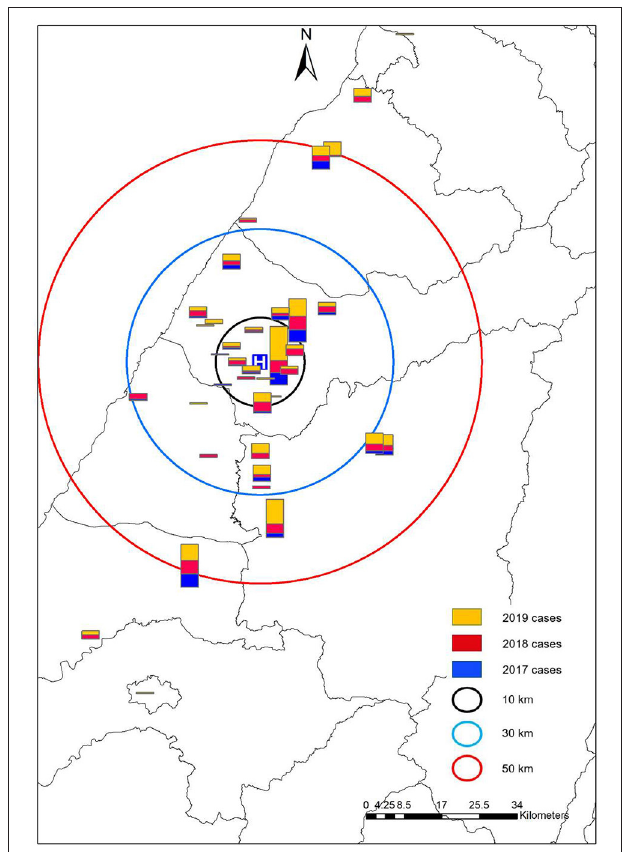
FIGURE 1 | The geographic distribution of primary stroke centers and the interhospital transfer cases. We found an increasing number of transfers in almost all the hospitals, irrespective of the distance.